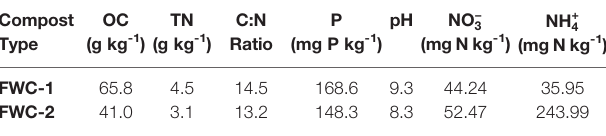
TABLE 2 | Comparison of chemical characteristics of the two types of food waste composts used in this study: compost sourced from Dar es Salaam (FWC-1) and compost generated in Mwanza